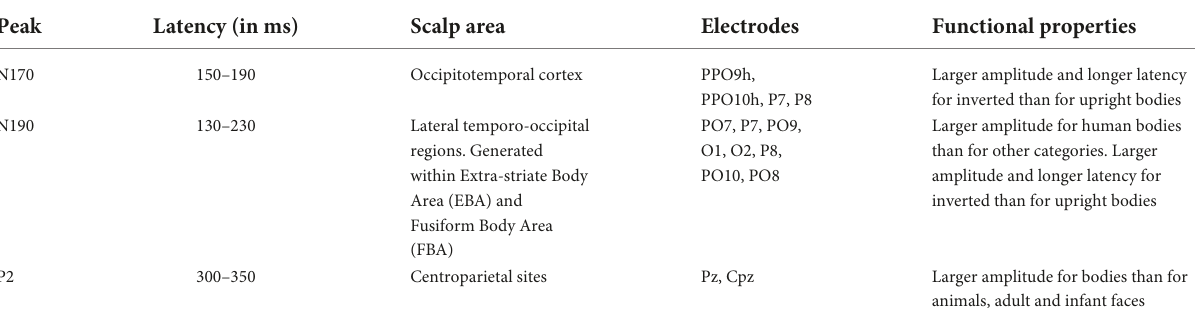
TABLE 2 Functional properties of several body-specific ERP components according to the literature (Downing et al., 2001; Thierry et al., 2006; Peelen and Downing, 2007; Taylor et al.,